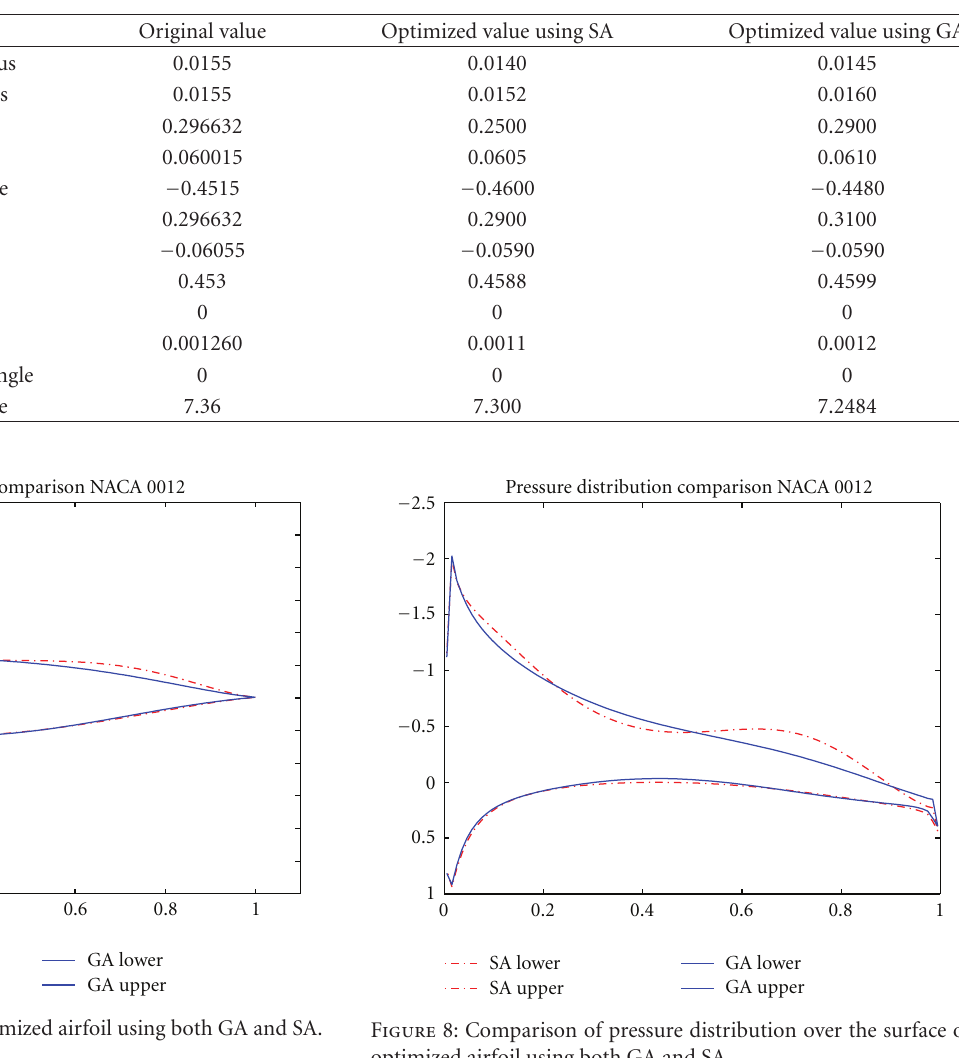
Table 2: Optimized PARSEC parameters.